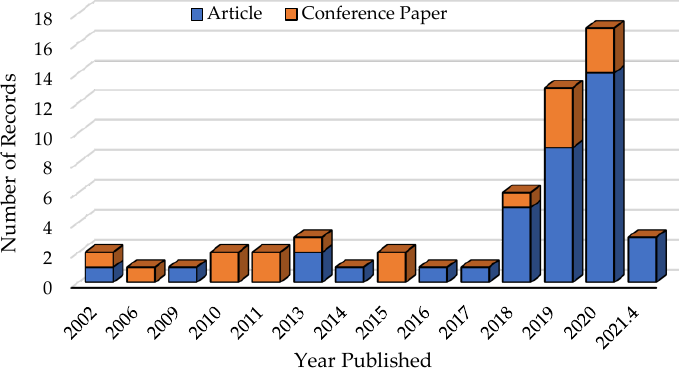
Figure 5. Yearly distribution of the number of selected papers (January 2000–April 2021).